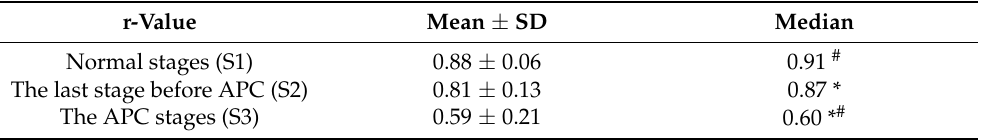
Table 4. The maximum r-value per stage using cross correlation coefficient in normal stages, the last stage before aerobic capability plateau (APC), and the APC stage.